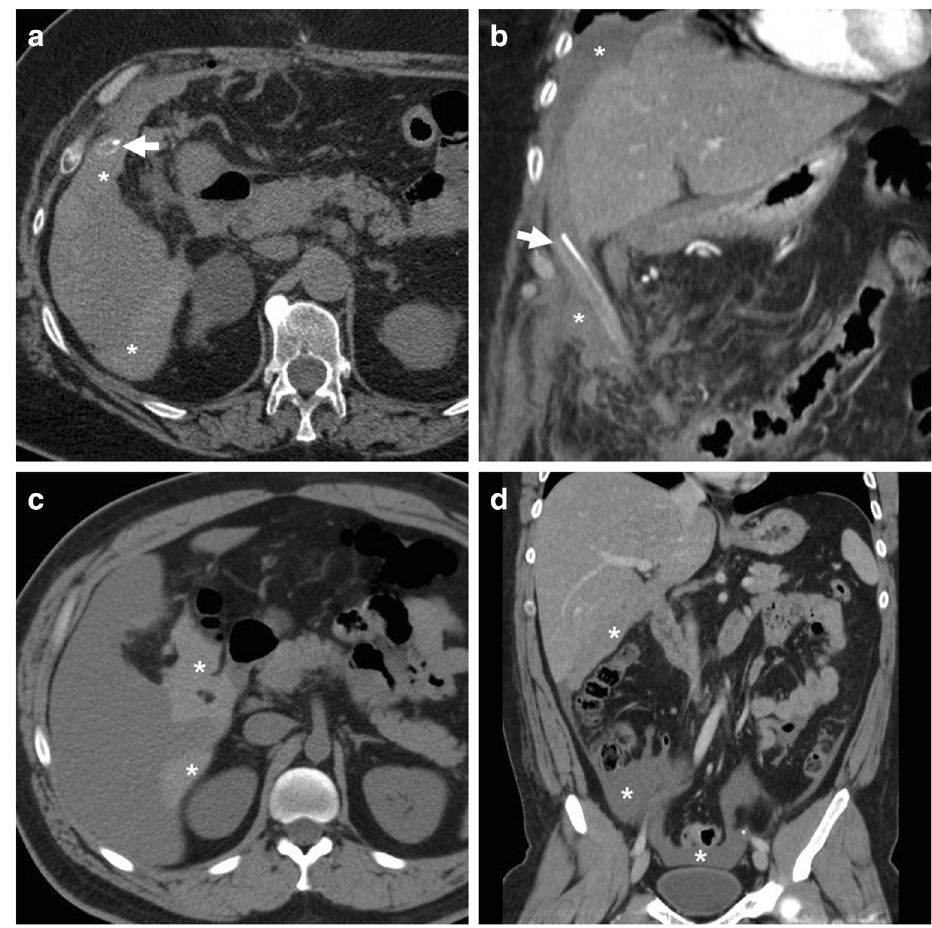
Fig. 11 Two cases of atypically located post-surgical infections. a Right subphrenic abscess (*) abutting the bare area of the liver 2 weeks after urgent laparoscopic cholecystectomy, which was treated by open surgical drainage (cultures positive for Klebsiella ). b , c Peripherally enhancing